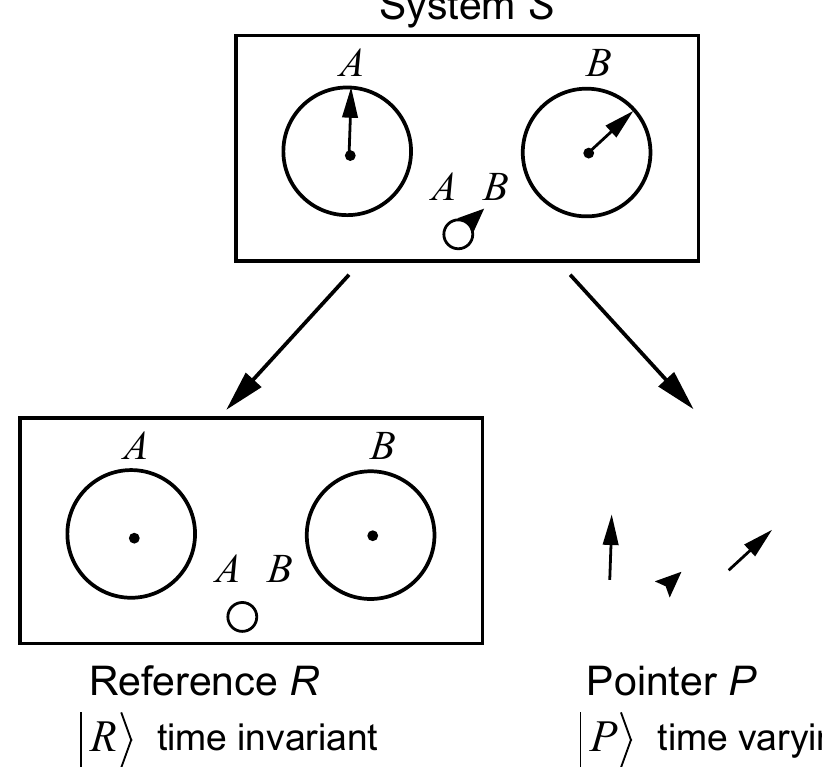
Figure 4: Identifying a system S requires identifying some proper component R that maintains a constant state | R ⟩ (or density of time-averaged samples ρ R ) as the “pointer” state | P ⟩ (or density of time-averaged samples ρ P ) of interest varies. Adapted from